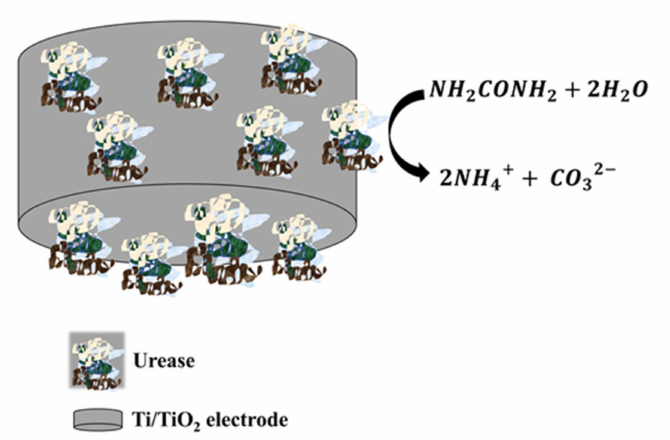
Figure 10. The enzymatic catalytic hydrolysis reaction in the vicinity of the urease functionalized Ti/TiO 2